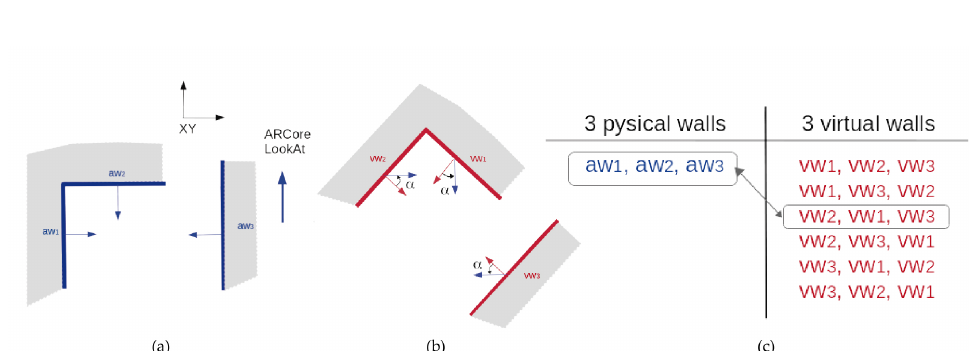
Figure 9. Angular offset α : ( a ) the scanned planes from real world, ( b ) the corresponding planes of the virtual world (red) and ( c ) pairs of real and virtual walls to be compared.